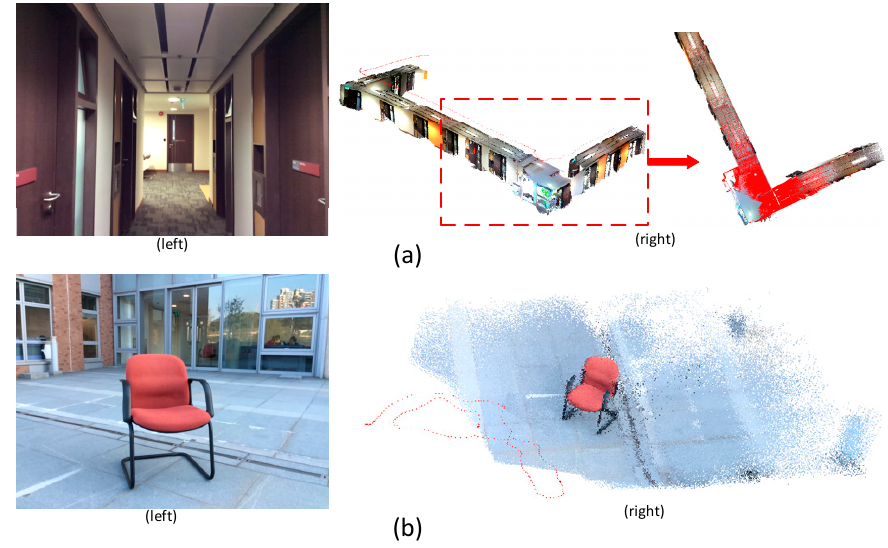
Figure 7. ( a ) Dataset captured along a corridor; and ( b ) dataset captured in the outside environment.